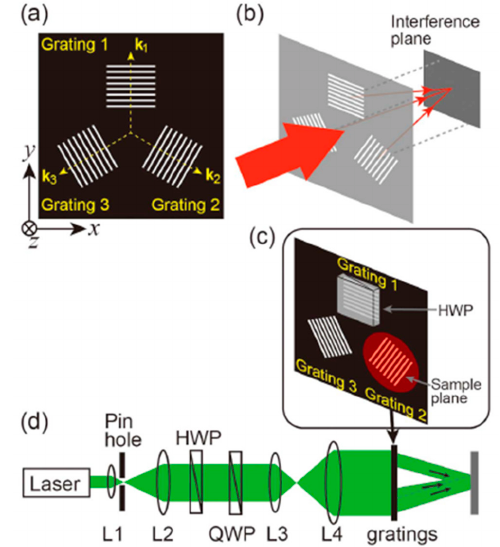
Figure 4. Representation of ( a ) the monolithic gratings, ( b ) interference of the diffracted beams, ( c ) monolithic gratings with the half-wave plate (HWP) and sample of birefringent medium, and ( d ) experimental setup designed for measuring birefringence distributions (Reproduced with permission from Shimomura et al. [32], OSA, 2018).